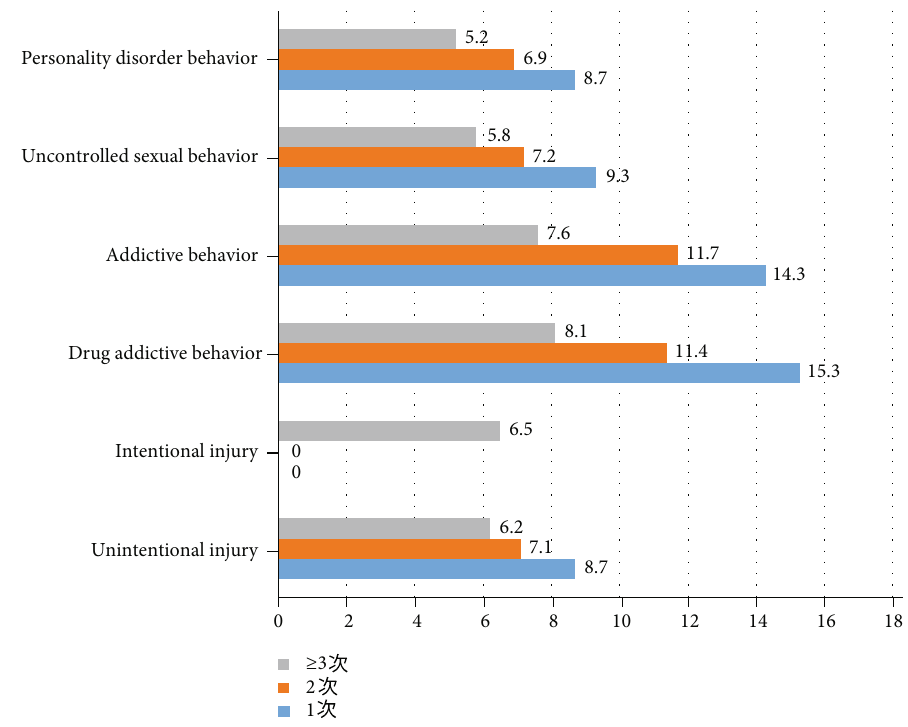
Figure 3: Visualization of the number of relapses after 3 years. Table 4: AHRB behavior of non-AHRB